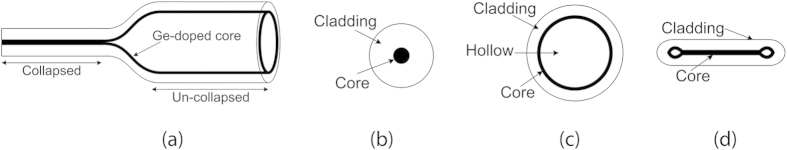
(a) Original Ge-doped preform, (b) Cylindrical fibre, (c) Capillary fibre, and (d) Flat fibre.